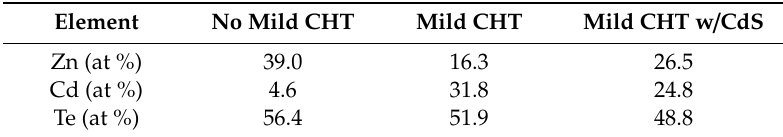
Table 3. Summary of EDX compositional data from ZnTe:As back contacted region of CdTe cells with and without additional mild CdCl 2 heat treatment (CHT).